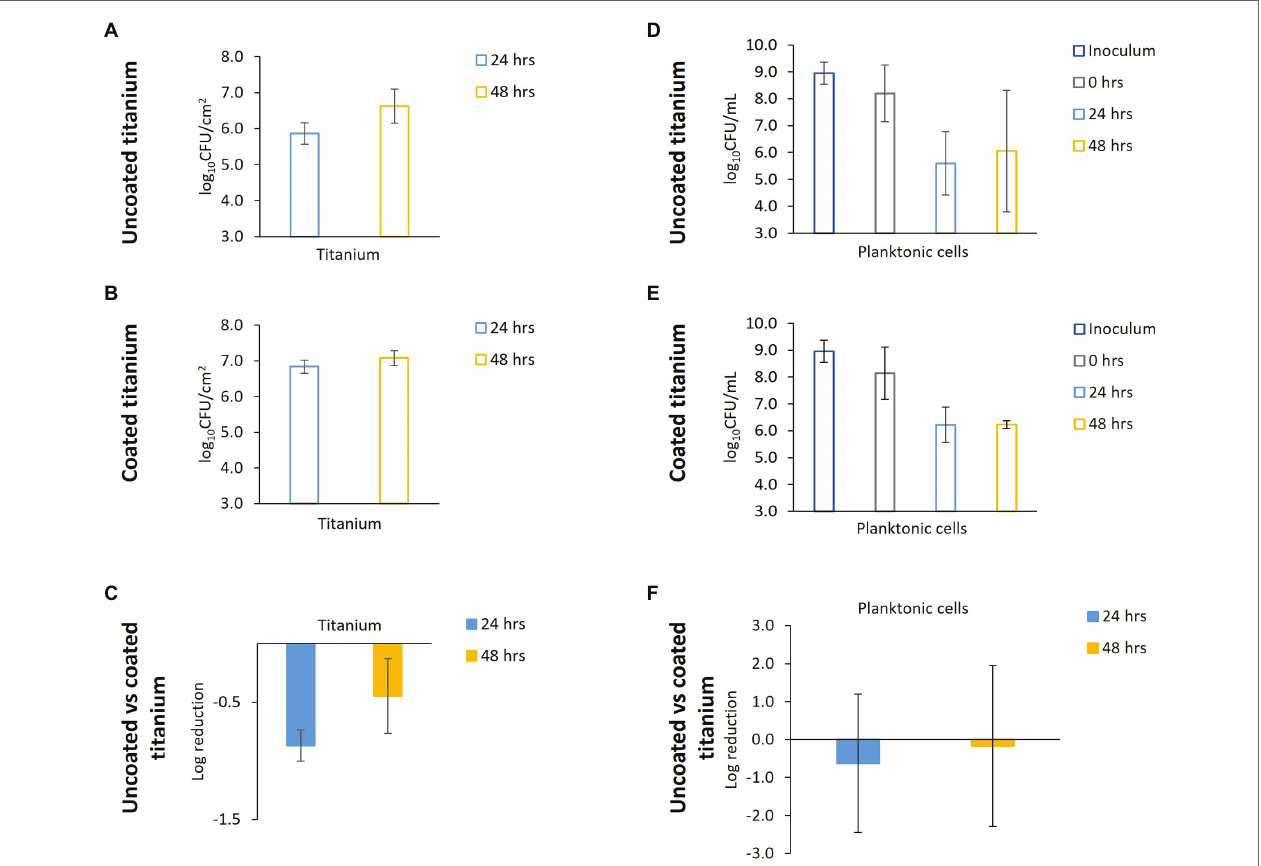
FIGURE 3 | Potato dextrose broth (PDB)-grown P. aeruginosa biofilm accumulation and planktonic cell density. PDB-grown P. aeruginosa biofilm cell densities at 24 and 48 h after start of continuous flow on (A) uncoated and (B) coated titanium. (C) Log reduction of TSB-grown biofilm accumulation on titanium at 24 and 48 h. Inoculum and planktonic cell densities at 0, 24, and 48 h after start of continuous flow for reactors with (D) uncoated and (E) coated titanium. (F) Log reduction of planktonic cells at 24 and 48 h. Negative log reductions indicate the coating resulted in higher cell densities. Error bars represent 95%